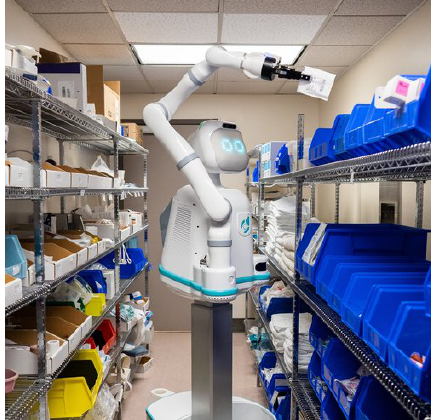
Figure 8. The Moxi robot gathering supplies